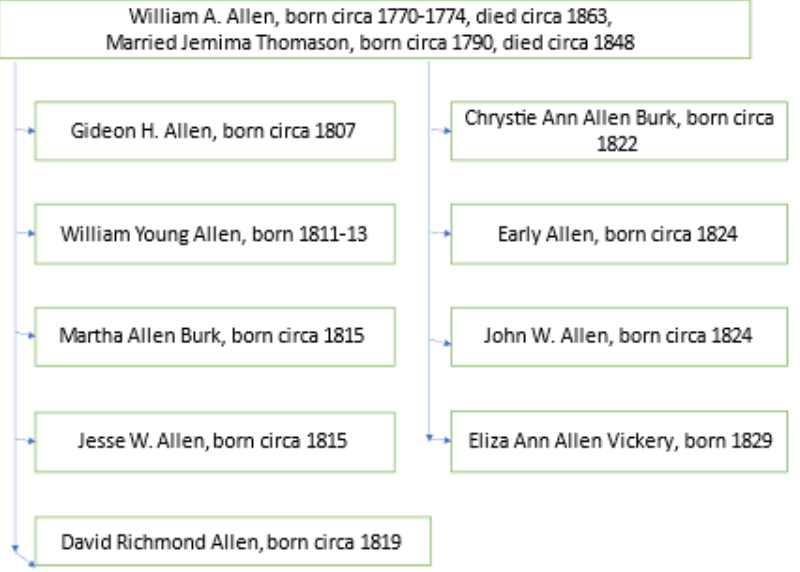
Figure 3. The Family of William A. Allen and Jemima Thomason. This chart identifies nine children of William A. Allen and Jemima Thomason, as discussed in this article.